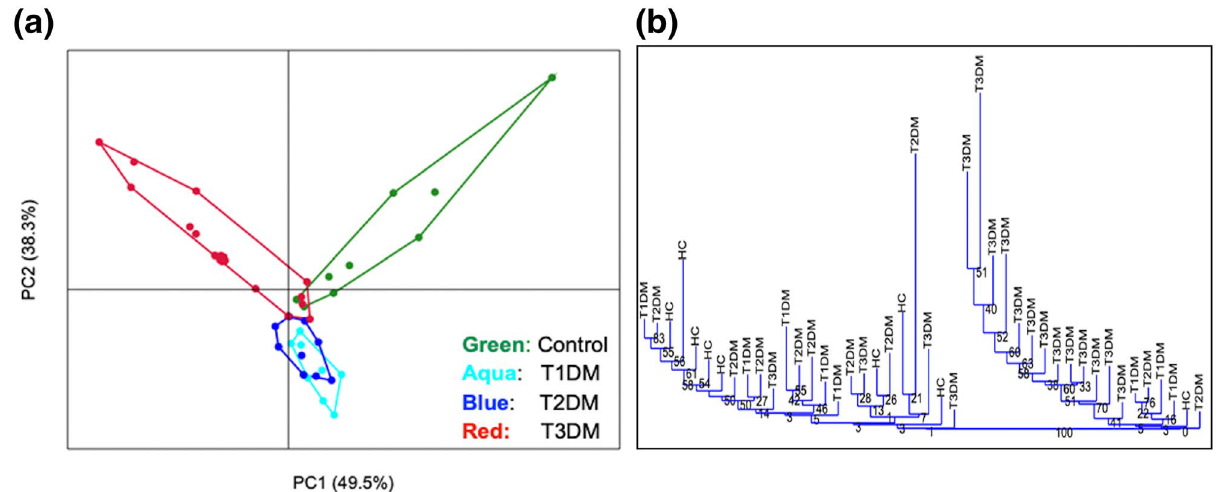
Figure 3. Clustering of gut microbiota at species level taxa among the study groups. ( a ) Principal component analysis (PCA) of gut microbial species abundance showing distinct clustering in the four study groups. The relation between the microbiota and disease status was assessed with PERMANOVA using 10,000 permutation [Bonferroni corrected p < 0.0001] followed by post hoc pair wise comparison. ( b ) Agglomerative clustering dendrogram showing hierarchical cluster analysis based on Euclidean similarity matrix (with boot strapping to 1000) to measure closeness between individual